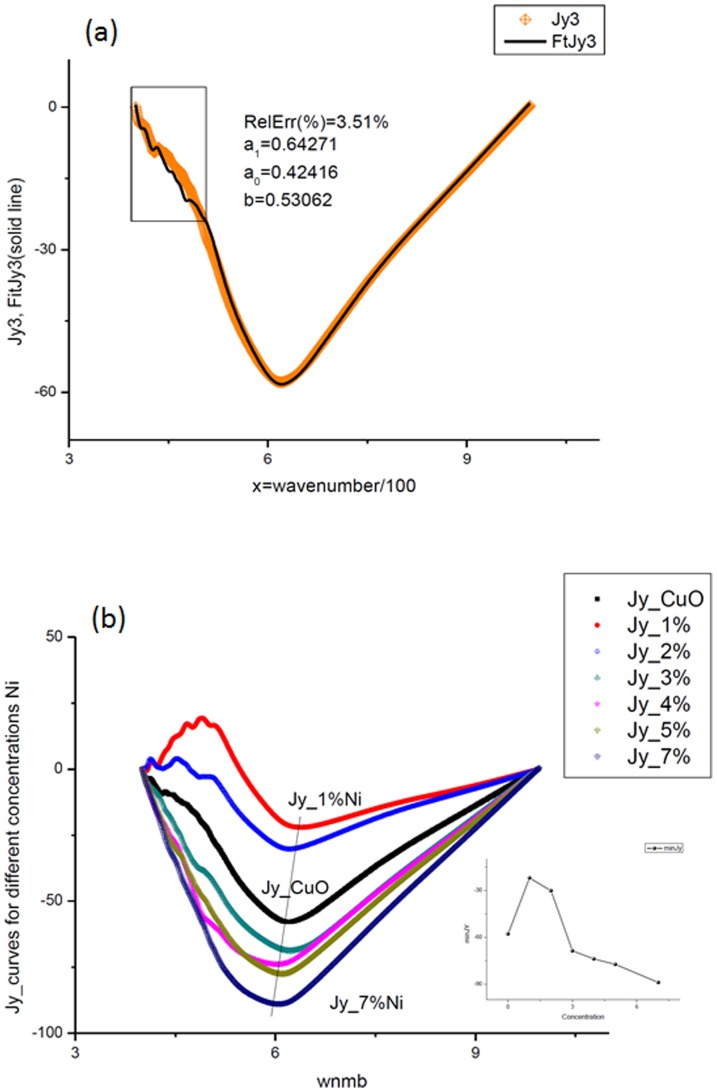
Hypothesis and integrated curve test results.(a). The results of the test of the hypothesis (3) is depicted on this figure. Linear combination of two previous measurements gives the acceptable fit (RelErr = 3.51%) of the integrated curve corresponding to the third measurement. The fitting constants from expression (3) are shown in the center of the figure. (b). This figure shows that integrated curves demonstrate the monotone behavior with respect to increasing of the doped Ni (1%→7%). More accurate behavior of this minimal point with respect to concentration is given in the small figure located on the right-hand side. We deliberately do not show the fitting curves to the function (6), which practically coincide with these curves. The value of the fitting error is located in the interval 0.1%<RelErr<1%.